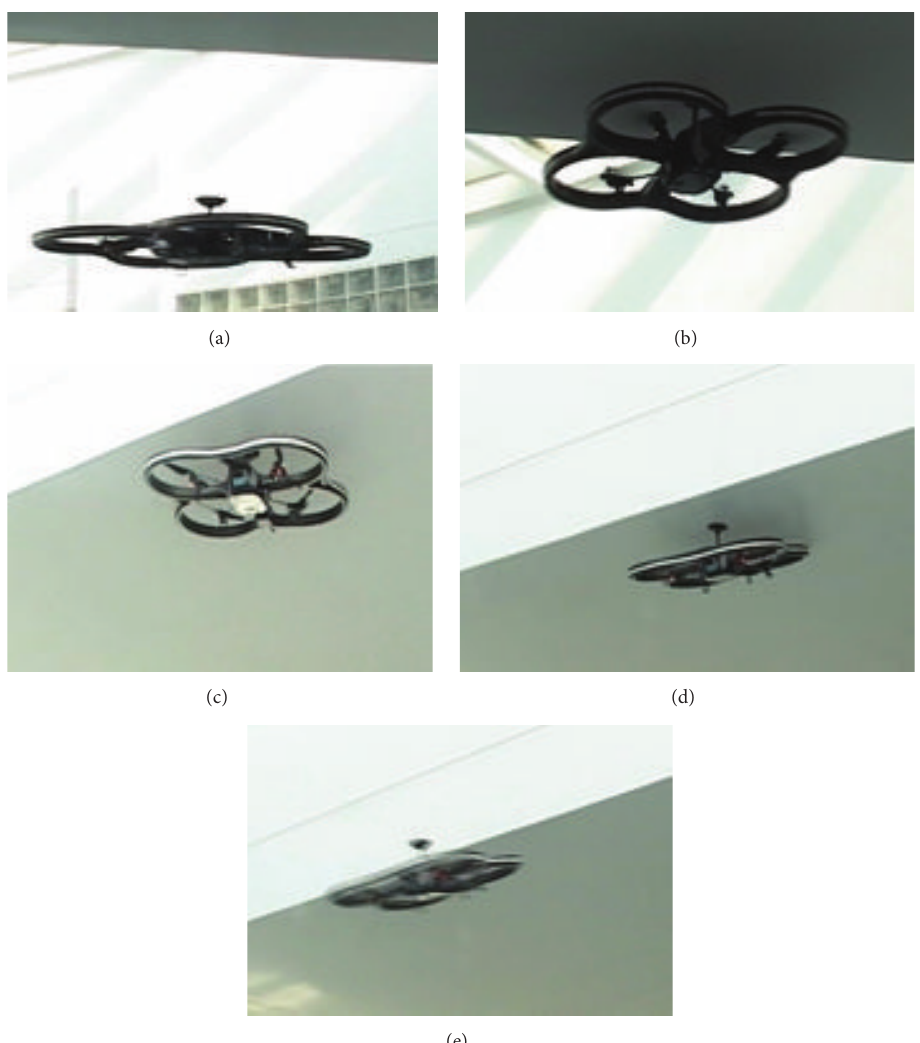
Figure 14: A group of sequences of experimental results of the top perching robot adsorbing on a ceiling. (a) Fly in the sky, (b) approach the ceiling and adsorb on the ceiling, (c) stop flying and perch on the ceiling, (d) start to fly from the nest, and (e) fly again in the sky. Conflict of